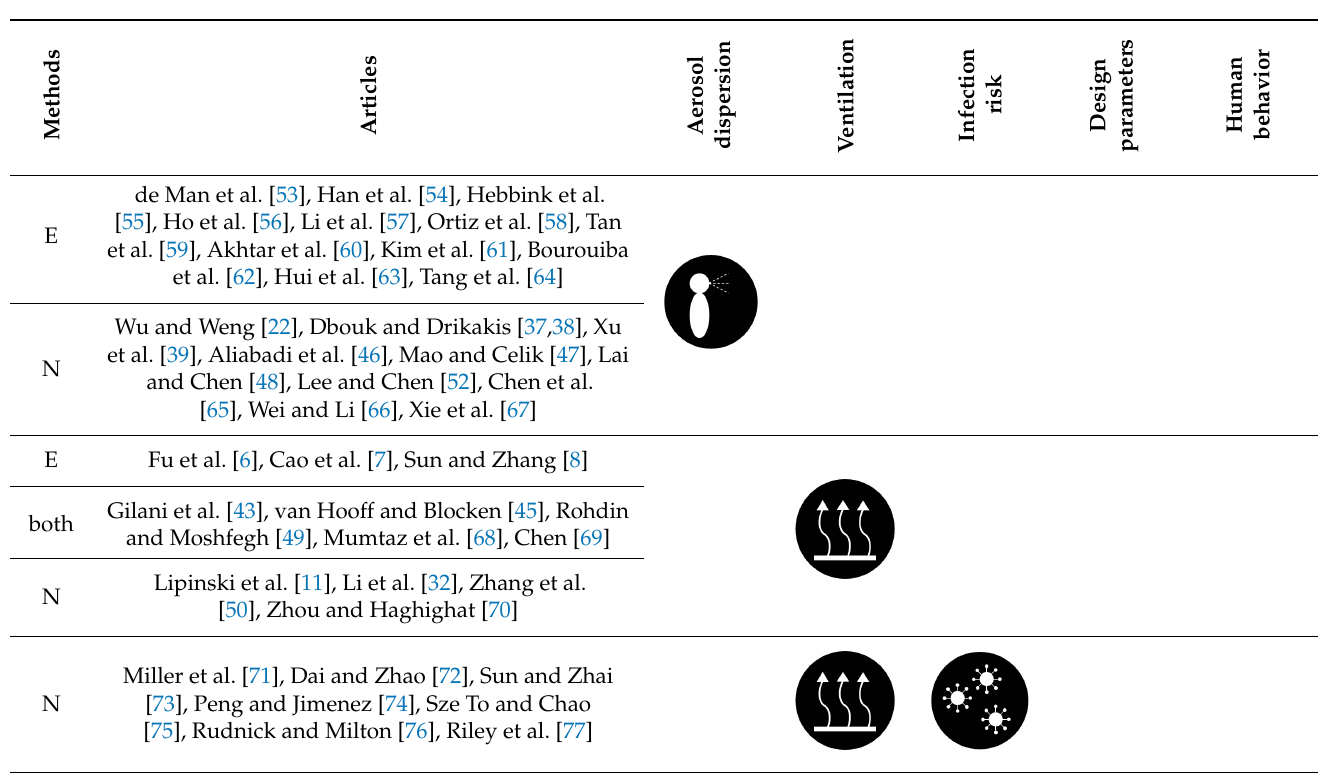
Table 3. Themes of the selected papers. E indicates experiments and N indicates numerical simula-